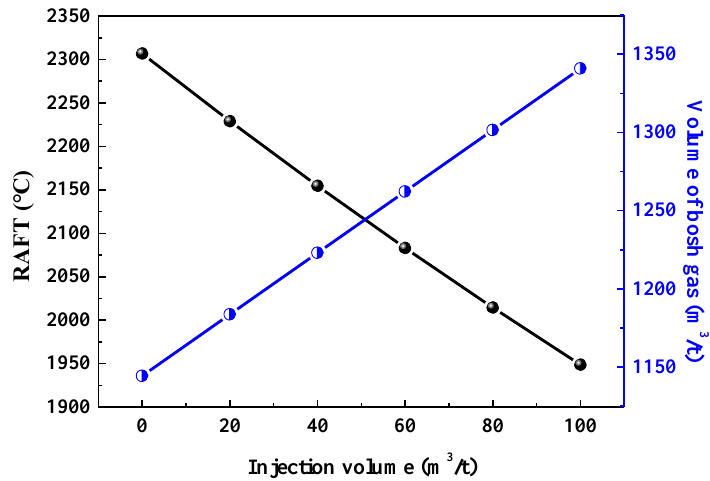
Figure 3. Effect of NG injection on the RAFT and volume of bosh gas.